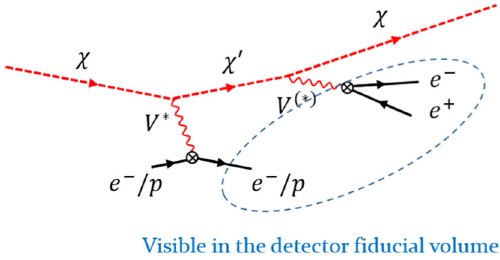
respectively. Existing constraints are shown in grey, and the relic den- sity target is shown as a black line. We also show for comparison the sensitivity curve expected for LDMX-Phase I (solid blue) [193]